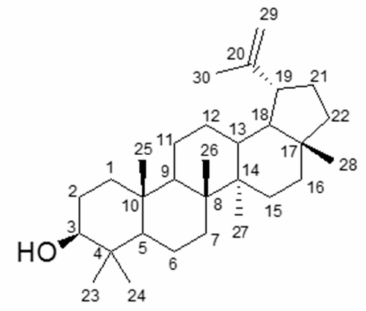
Figure 2. Chemical structure of lupeol.